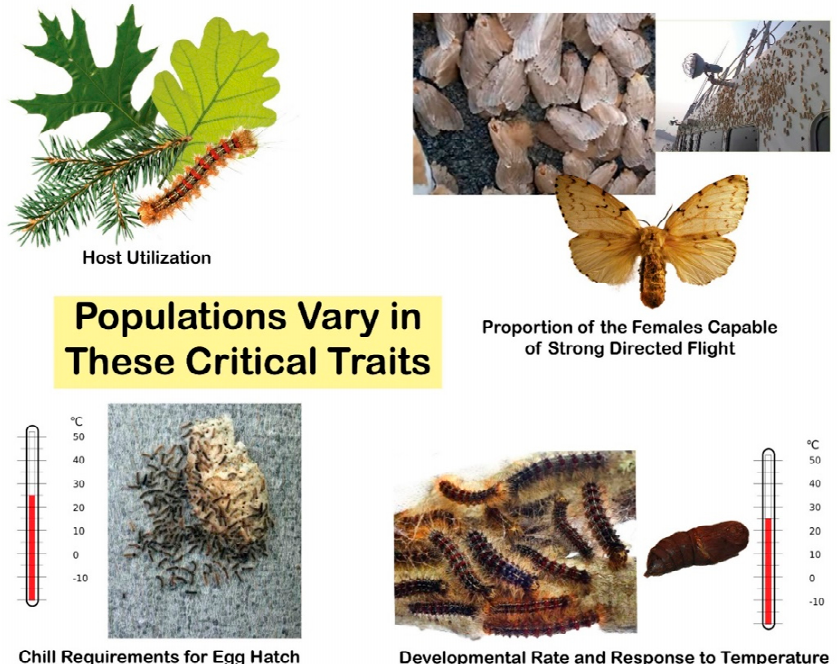
Figure 1. Gypsy moth populations vary in several key traits that can alter the dispersal capabilities or their potential to cause damage in novel habitats.